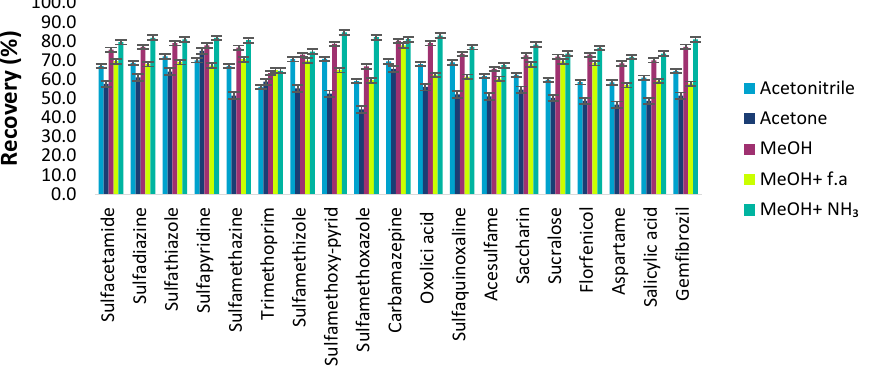
Figure 6. Effect of the desorption solvent on the recoveries of ECs.